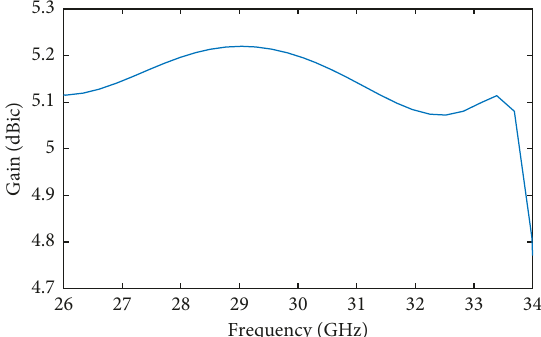
Figure 15: Simulated AR of the proposed antenna.